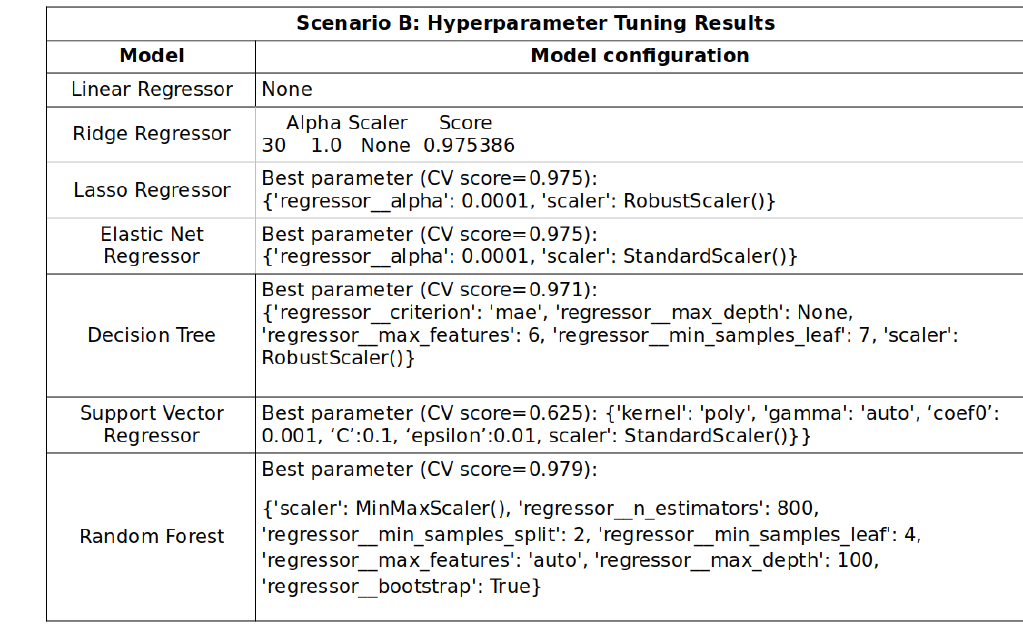
Figure A2. Hyperparameter configuration for the models of Scenario B.